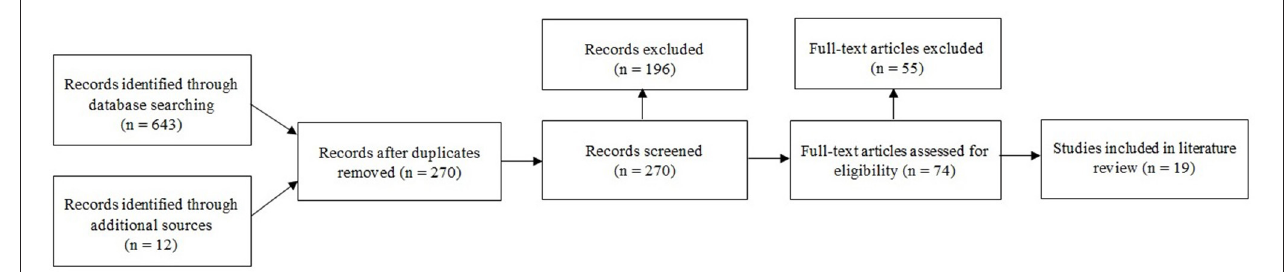
FIGURE 1 | Flow diagram of search